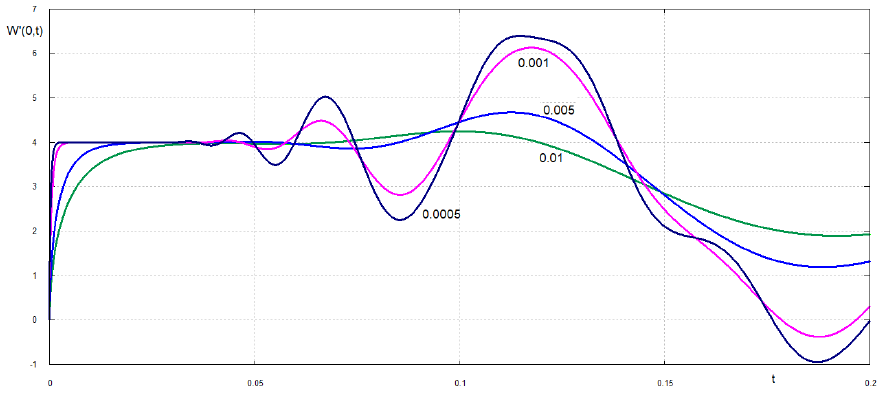
Figure 6. Dimensionless velocity of the plate edge W t ( 0, t ) shortly after after the plate breaking for very small values of the dimensionless retardation time ˜ τ = 0.01,0.005,0.001,0.0005.